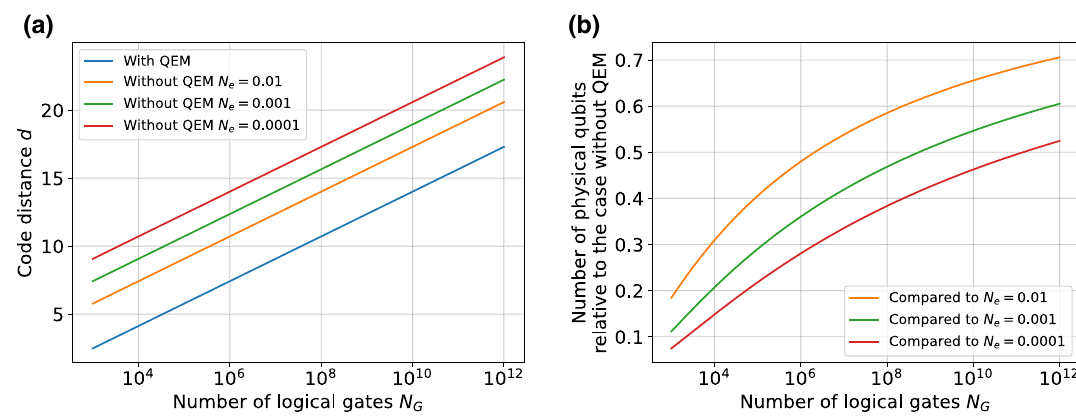
FIG. 10. (a) The relation between the required number of gates for executing algorithm N G and the required code distance for encoding the information of qubit d . The relation is plotted for several numbers of allowed logical error counts during FTQC N e . (b) The ratio between the number of required physical qubits per logical qubit with and without